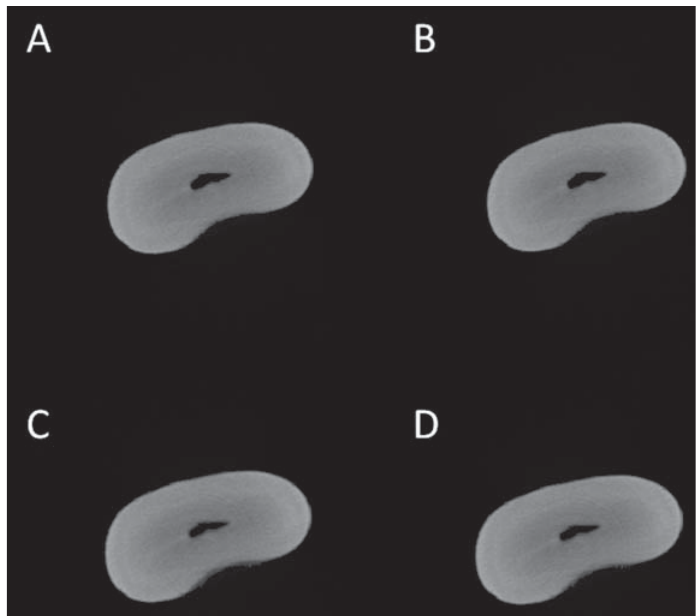
Figure 2- (cid:3)(cid:36)(cid:91)(cid:76)(cid:68)(cid:79)(cid:3)(cid:86)(cid:79)(cid:76)(cid:70)(cid:72)(cid:86)(cid:3)(cid:82)(cid:73)(cid:3)(cid:87)(cid:75)(cid:72)(cid:3)(cid:85)(cid:82)(cid:82)(cid:87)(cid:3)(cid:86)(cid:72)(cid:79)(cid:72)(cid:70)(cid:87)(cid:72)(cid:71)(cid:3)(cid:69)(cid:92)(cid:3)(cid:71)(cid:76)(cid:73)(cid:73)(cid:72)(cid:85)(cid:72)(cid:81)(cid:87)(cid:3)(cid:86)(cid:72)(cid:74)(cid:80)(cid:72)(cid:81)(cid:87)(cid:68)(cid:87)(cid:76)(cid:82)(cid:81)(cid:3)(cid:80)(cid:72)(cid:87)(cid:75)(cid:82)(cid:71)(cid:86)(cid:17)(cid:3)(cid:36)(cid:29)(cid:3)(cid:68)(cid:88)(cid:87)(cid:82)(cid:80)(cid:68)(cid:87)(cid:76)(cid:70)(cid:3)(cid:80)(cid:72)(cid:87)(cid:75)(cid:82)(cid:71)(cid:30)(cid:3)(cid:37)(cid:29)(cid:3)(cid:89)(cid:76)(cid:86)(cid:88)(cid:68)(cid:79)(cid:3)(cid:80)(cid:72)(cid:87)(cid:75)(cid:82)(cid:71)(cid:3)(cid:177)(cid:3)(cid:40)(cid:91)(cid:68)(cid:80)(cid:76)(cid:81)(cid:72)(cid:85)(cid:3)(cid:6)(cid:3)(cid:20)(cid:30)(cid:3)(cid:38)(cid:29)(cid:3)